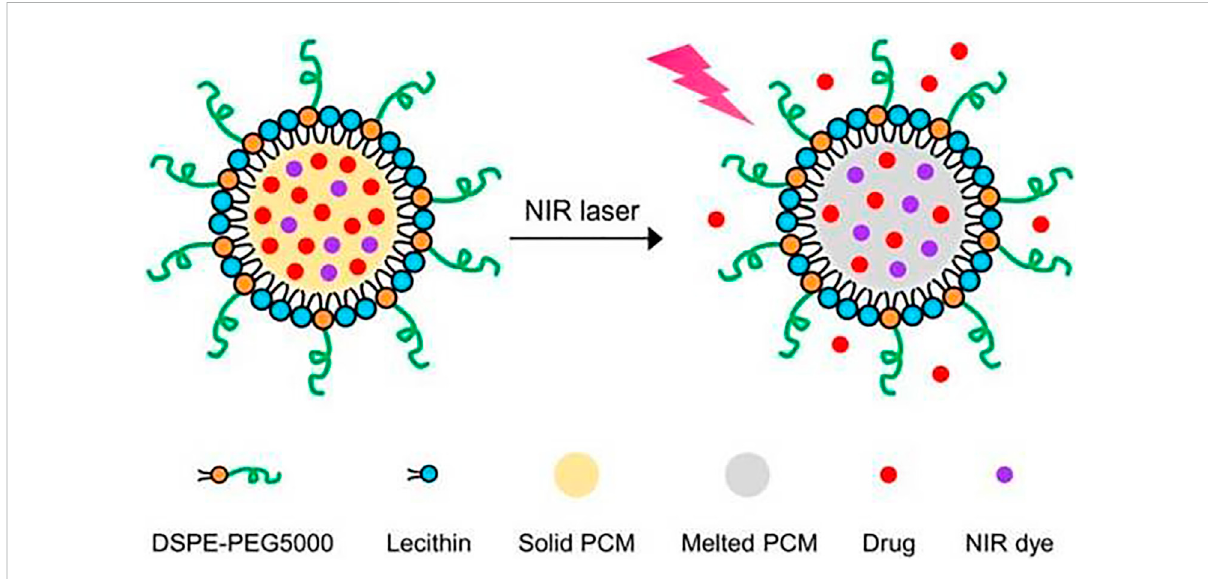
FIGURE 2 Schematic illustration showing the NIR-triggered release of drug molecules from a PCM nanoparticle made of a eutectic mixture of two fatty acids. Reproduced from Ref Chunlei et al.(2017). with